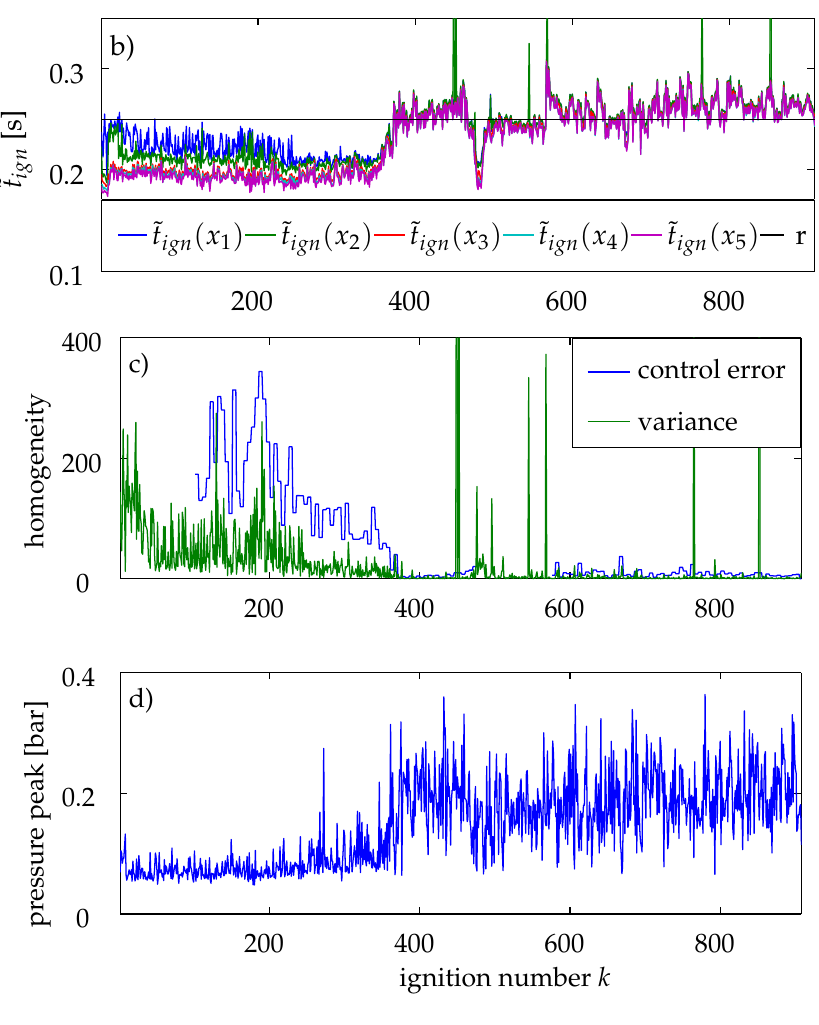
Figure 6. Experiment with 900 successful combustion cycles (9% of the ignitions are misfiring and not included in the diagram for clarity). ( a ) Control parameters defining the control profile of the fuel valve; ( b ) Ignition times detected by the photodiodes; ( c ) Homogeneity of the ignition evaluated by the variance and by the control error that is calculated for every five consecutive ignitions when the controller is active; ( d ) Maximum pressure increase due to the ignition.